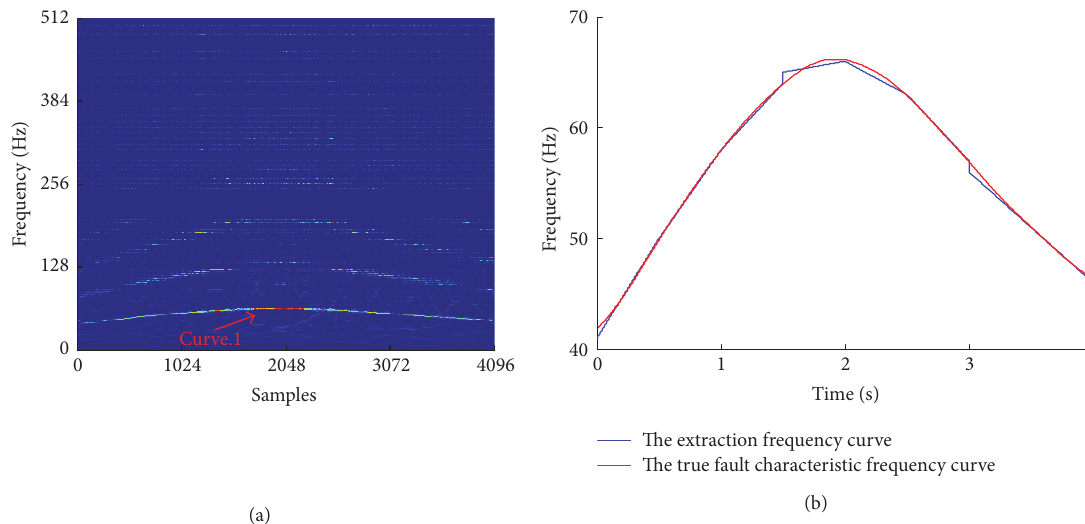
Figure 19: The time-frequency spectrum and the frequency curve. (a) The time-frequency spectrum obtained by the SST method; (b) the extraction and the true fault characteristic frequency curve.